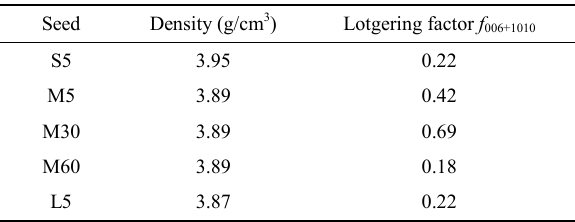
Table 1 Effect of morphology, size, and amount of template grains on the texture degree of α-Al 2 O 3 ceramics